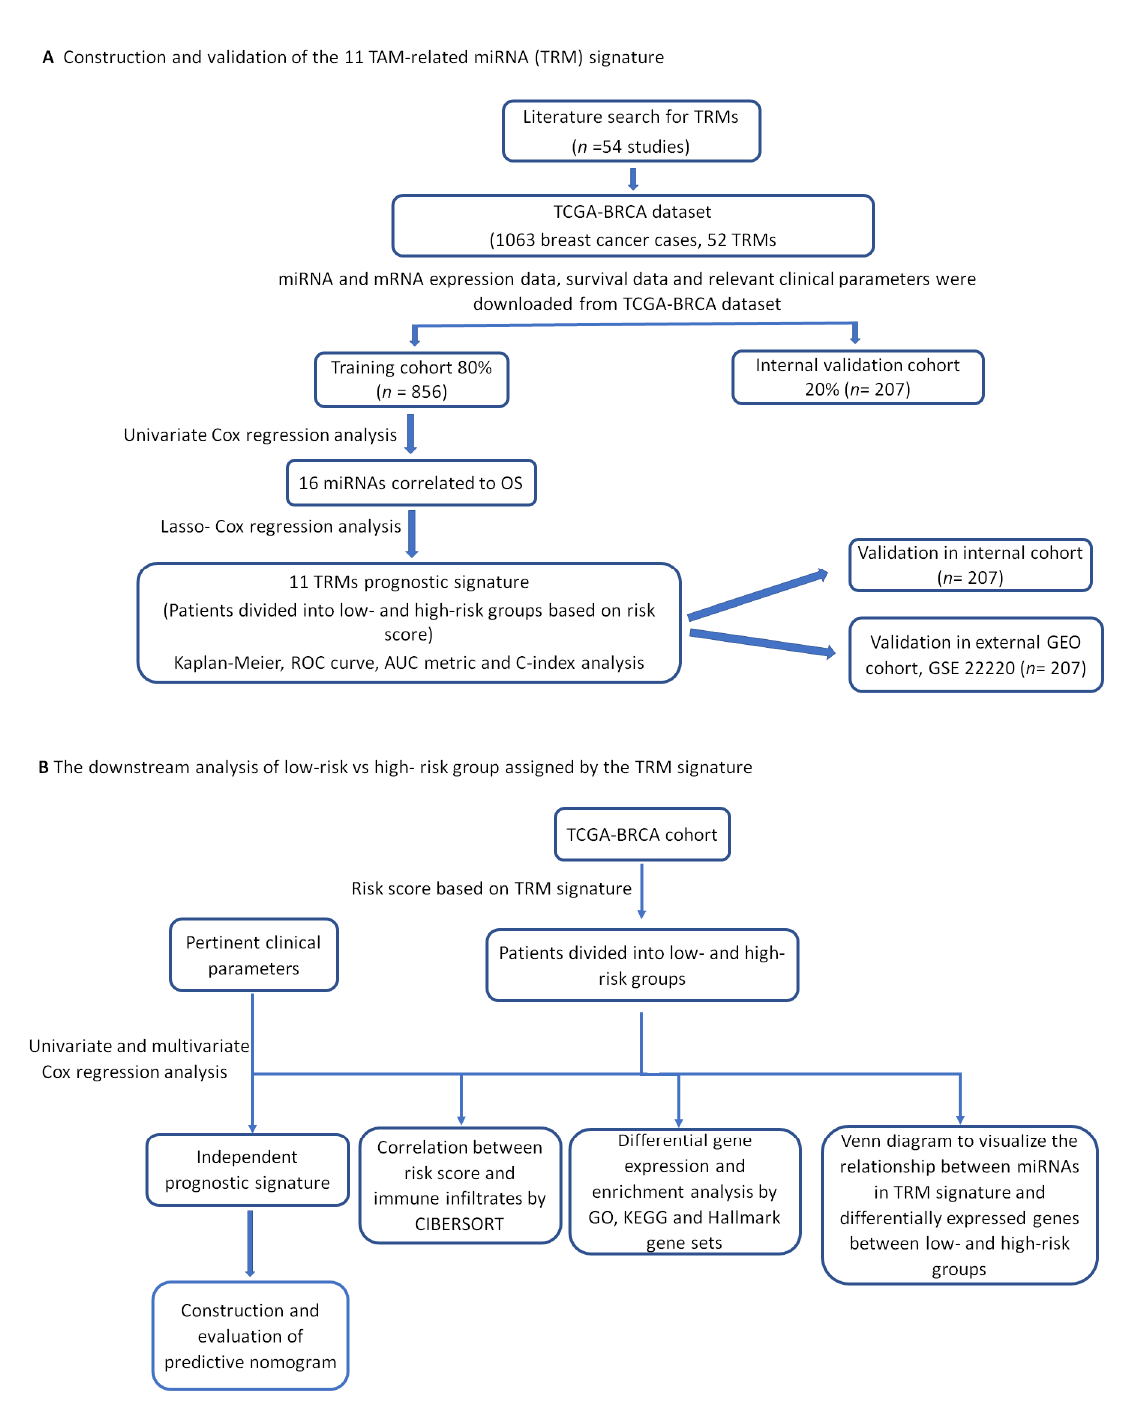
Figure 1. The overall workflow describing the process involved in the construction of 11TAM-related miRNA signature. ( A ) Flow chart describing the process involved in developing and validating the prognostic significance of the 11TAM-related miRNA signature. ( B ) Flow chart showing the prognostic independence evaluation and downstream analysis of high-risk vs. low-risk group assigned by the TRM signature.